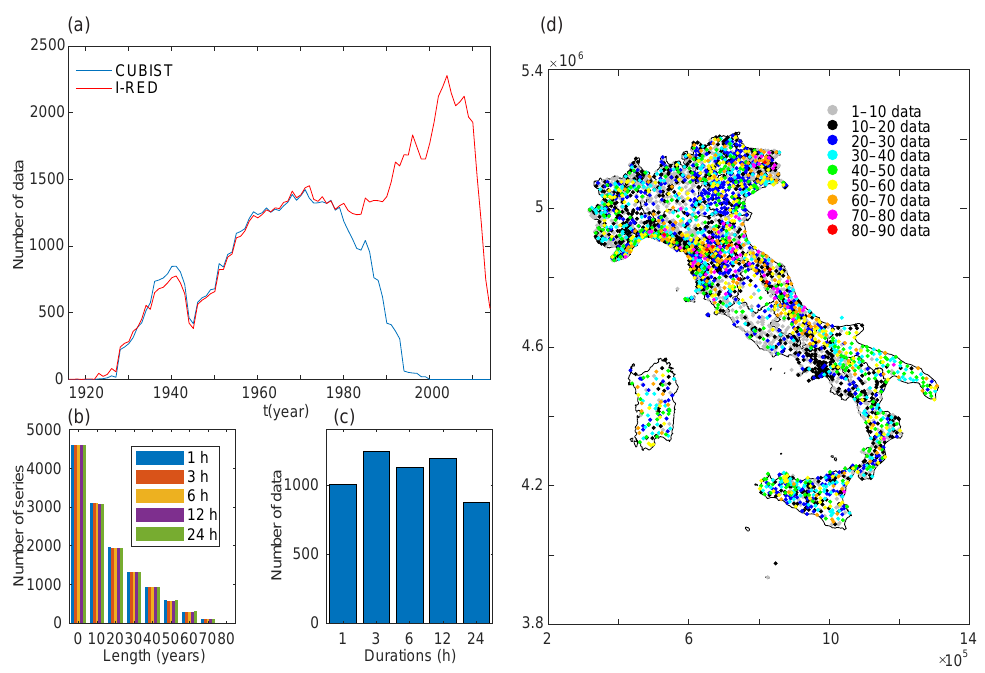
Figure 2. (a) Data availability per year in the I-RED and CUBIST databases (the smallest value across the five considered durations is reported per year). (b) Number of series longer than fixed threshold values in the I-RED databases per duration (null values are ignored). (c) Number of null values per duration. (d) Length of the series in the I-RED database represented in space: the colour refers to the minimum length among the five available durations. If more stations overlap due to the resolution of the picture, the one with the longer series appears on the